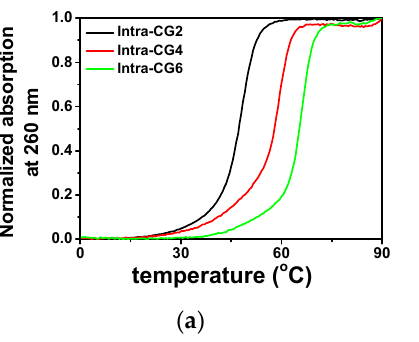
Figure 4. Normalized UV melting curves of ( a ) intramolecular triplexes and ( b ) intermolecular triplexes at 260 nm in the buffer containing 50 mM MES, 0.1 M KCl, and 40 wt% PEG 200 at pH 6.0.